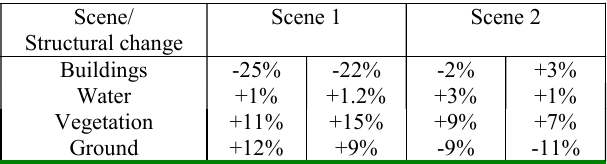
Table 2 . Detection of structural changes from the QuickBird to the WorldView images by means of the proposed methodology. The left column is derived from the usage of the indices of (Panagiotopoulou, Ragia, 2021) and the right column results from the indices of (Gupta et al., 2018; Tsikdogan et al., 2019). Change detection is also performed by means of the unsupervised technique which is presented in (Celik, 2009). K- means clustering is applied on feature vectors which are extracted using local data projection onto eigenvector